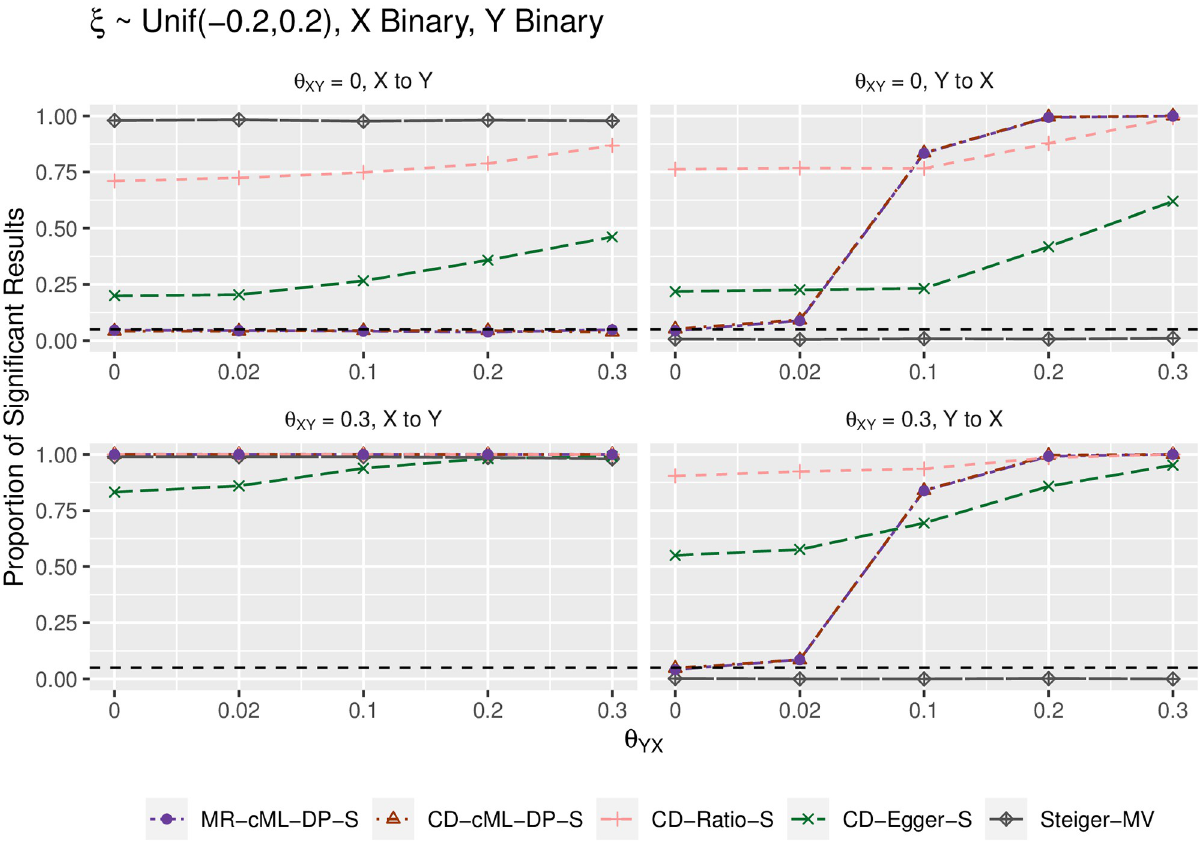
Fig 5. Empirical type-I error and power (y-axis) for both X and Y binary, ξ from a uniform distribution (i.e. with correlated pleiotropy, implying InSIDE violated), θ = 0 (top panels) and θ = 0.3 (bottom) for various values of θ (x-axis). The left panels show results for the direction X ! Y , XY XY YX the right ones show results for the direction Y ! X .